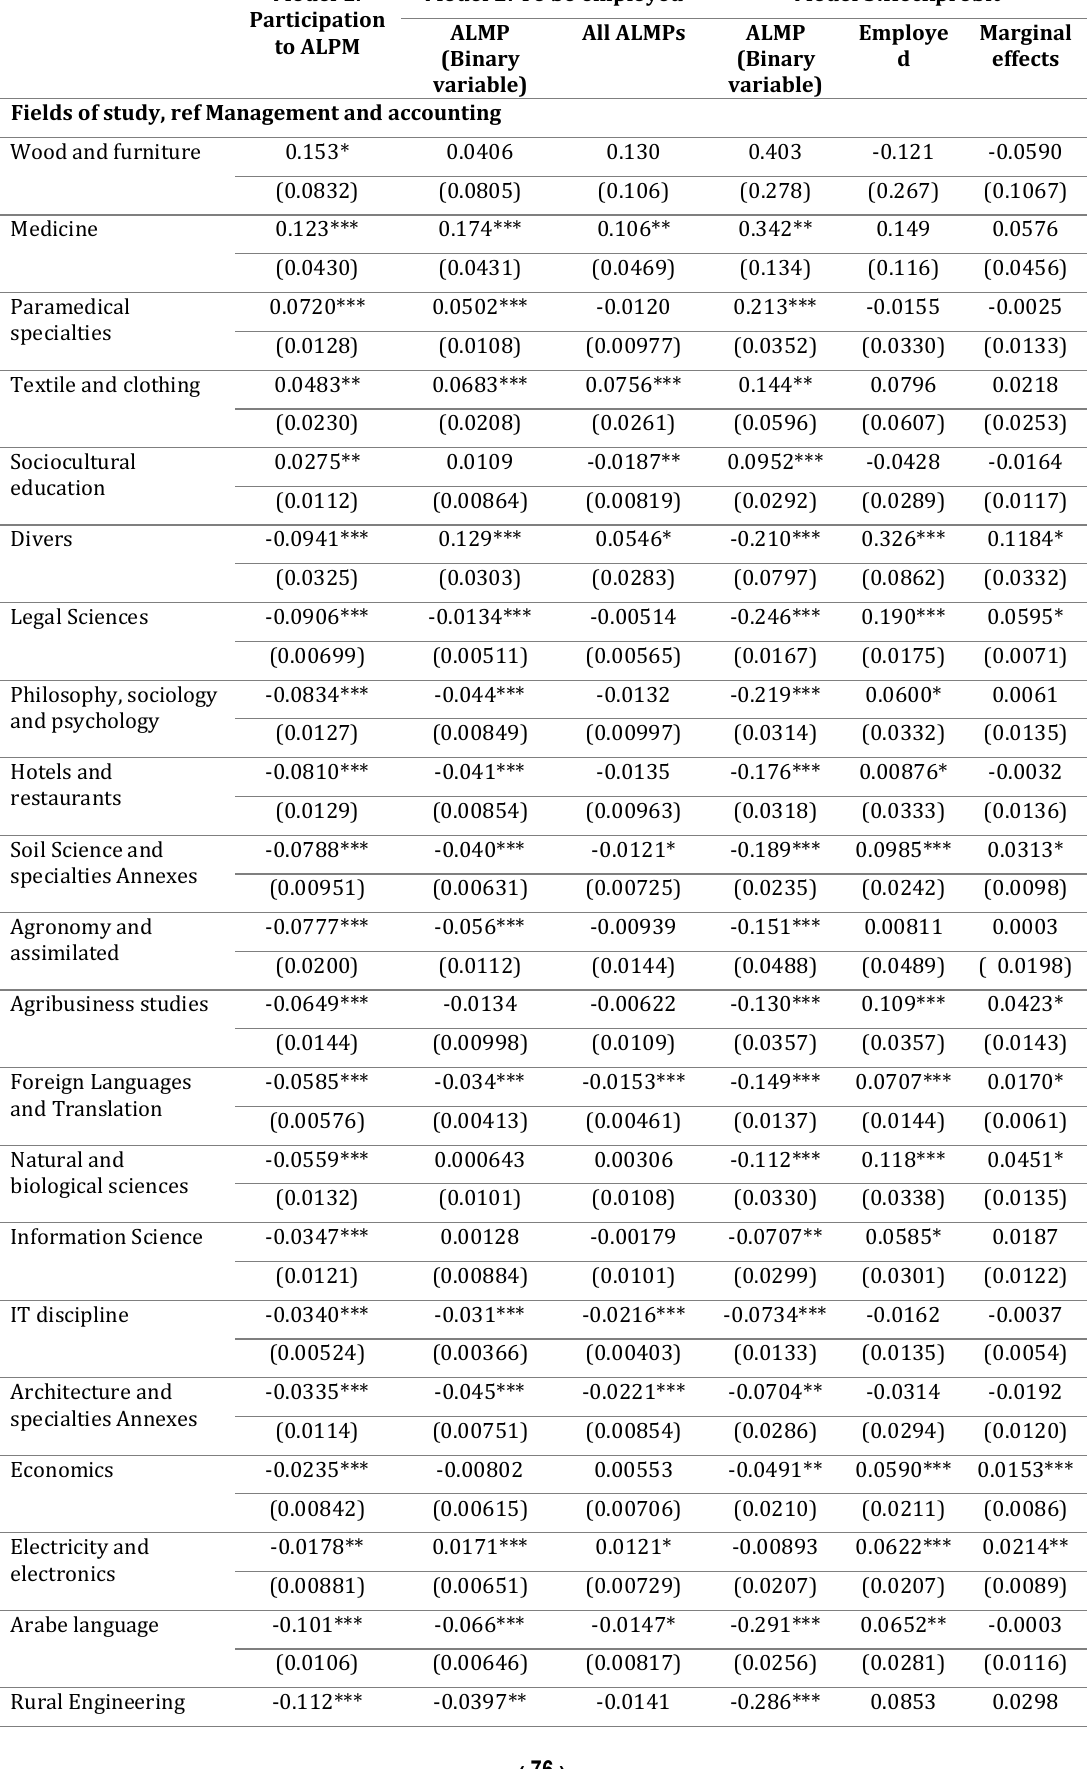
Table 8: Fields of studies impacts on ALMPs participation and professional